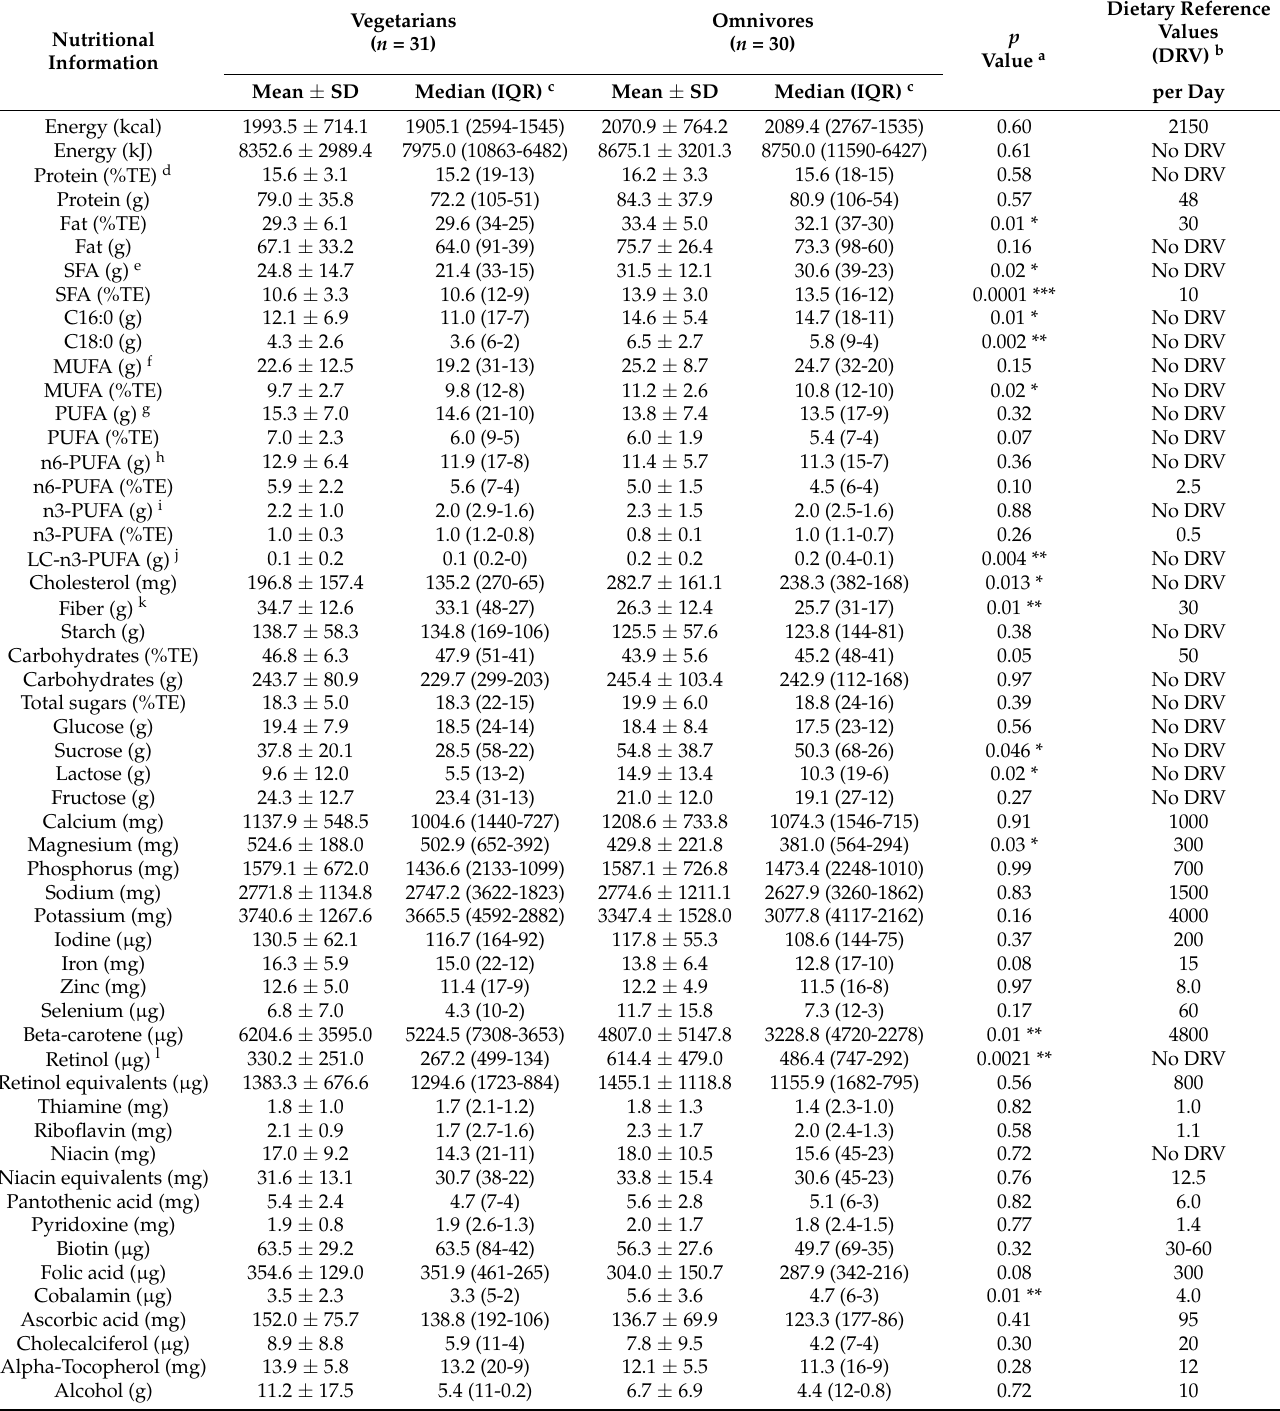
Table 2. Energy and nutrient intakes of female German